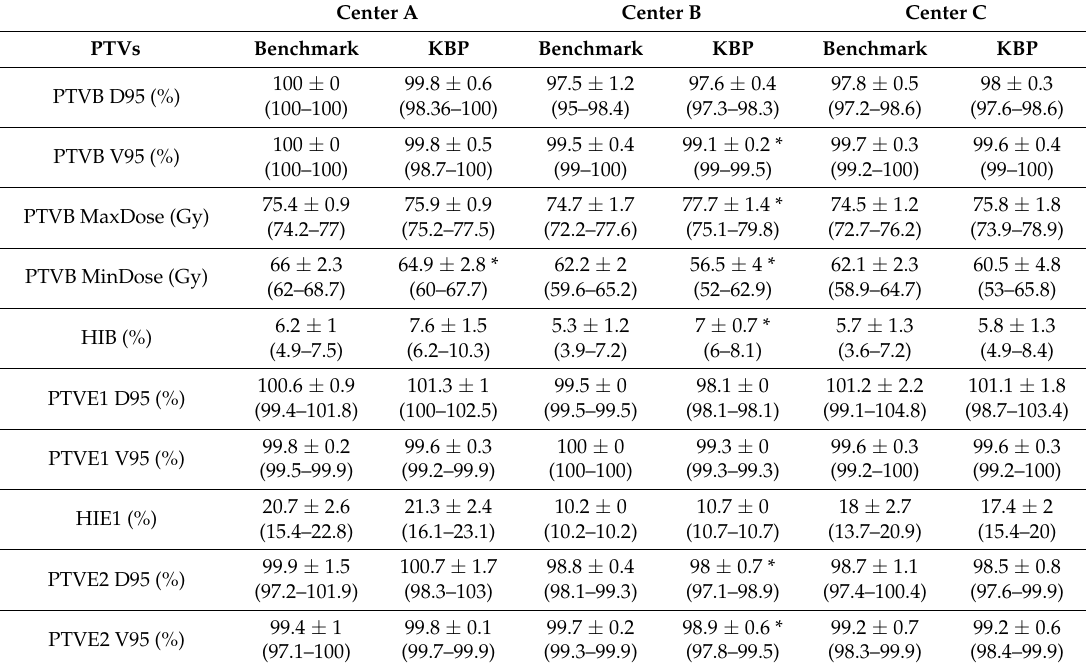
Figure 3. Benchmark plan ( ■ ) and KBP ( ▲ ) dose-volume histograms for one patient from Center-A ( A , B ), Center-B ( C , D ), Center-C ( E , F ). Targets: PTV B (Pink), PTV E1 (magenta), PTV E2 (orange). Organs-at-risk: brainstem (dark-grey), oral cavity (purple), constrictors (green), larynx (red), esophagus (brown), left parotid (pink), right parotid (blue), spinal cord (petroleum-blue). Table 1. Dosimetry averaged for the 7 benchmark plans and KBPs from each of the three external centers. Wilcoxon signed rank tests were used to identify significant ( p < 0.05) differences between benchmark plans and KBPs, with * indicative of such differences.